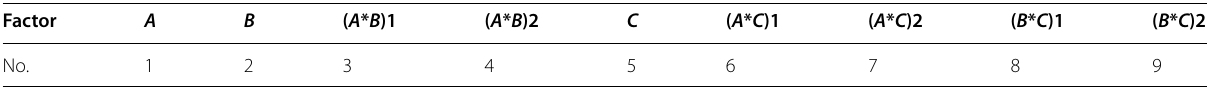
Table 6 Multi-factor header design